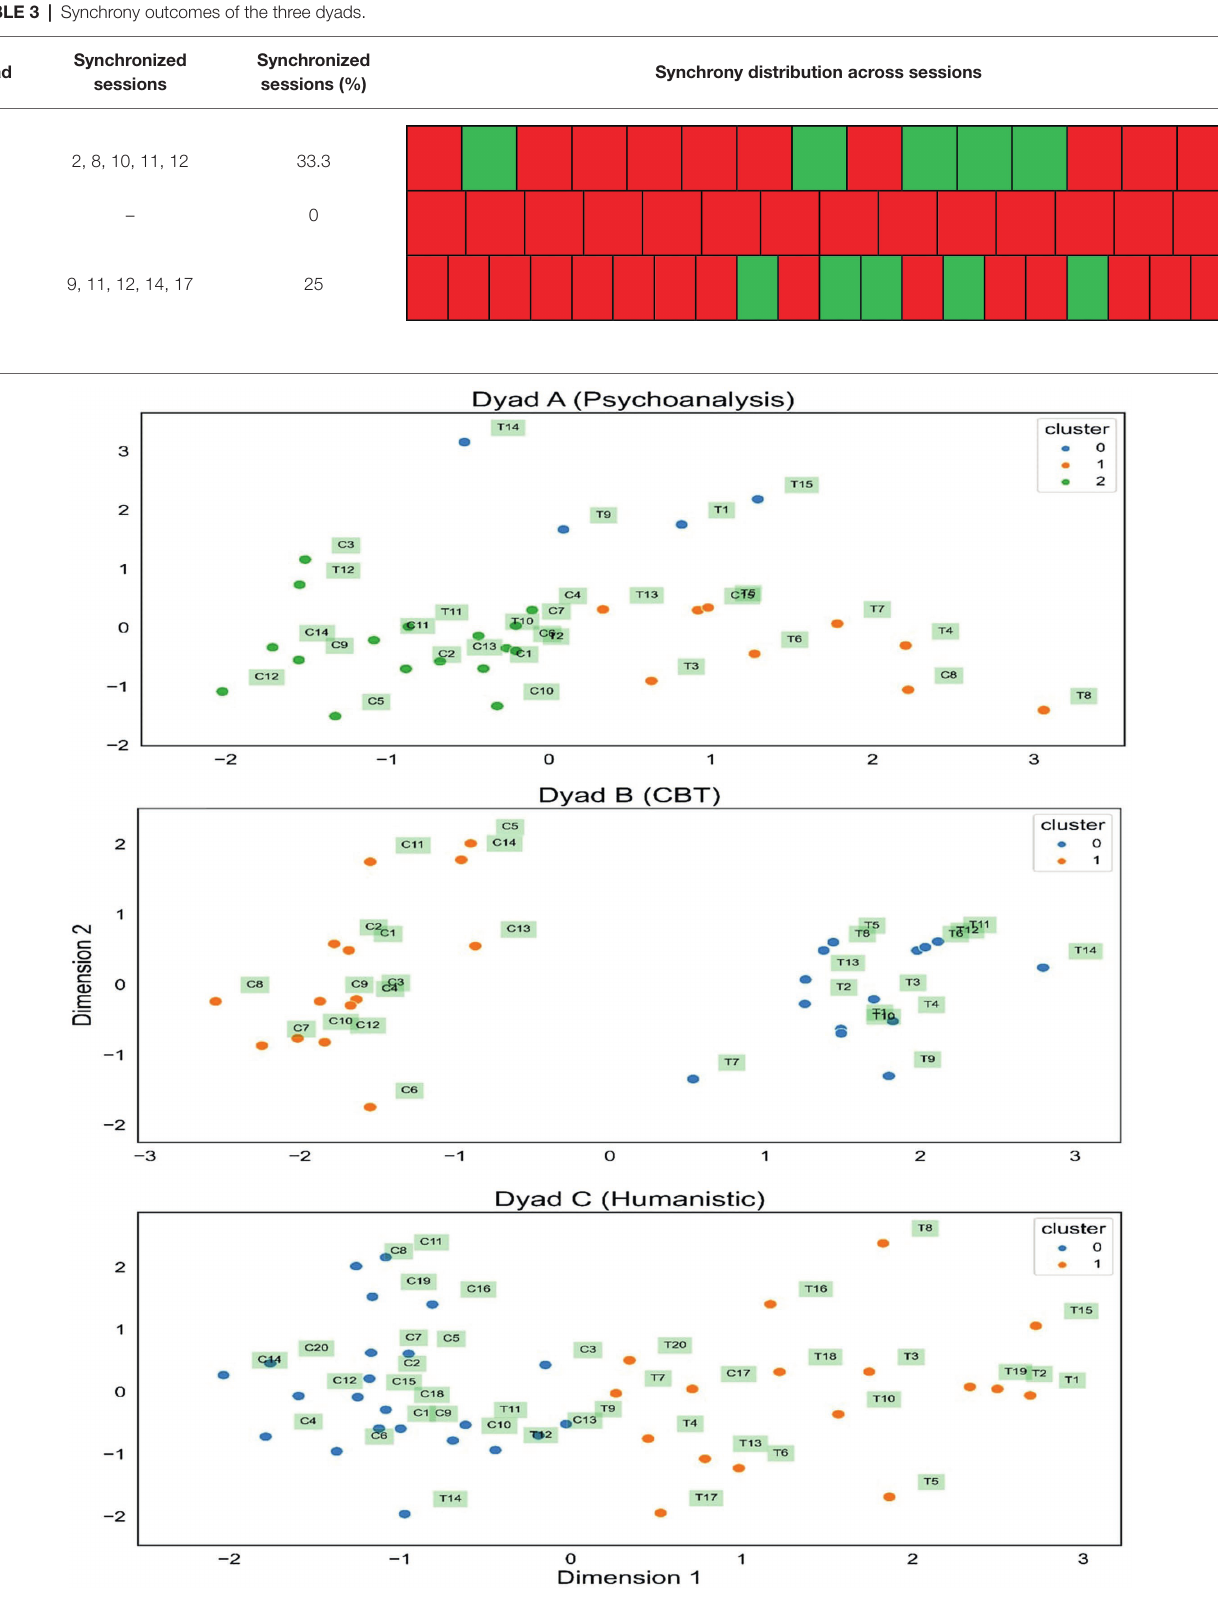
FIGURE 3 | Cluster membership in the three